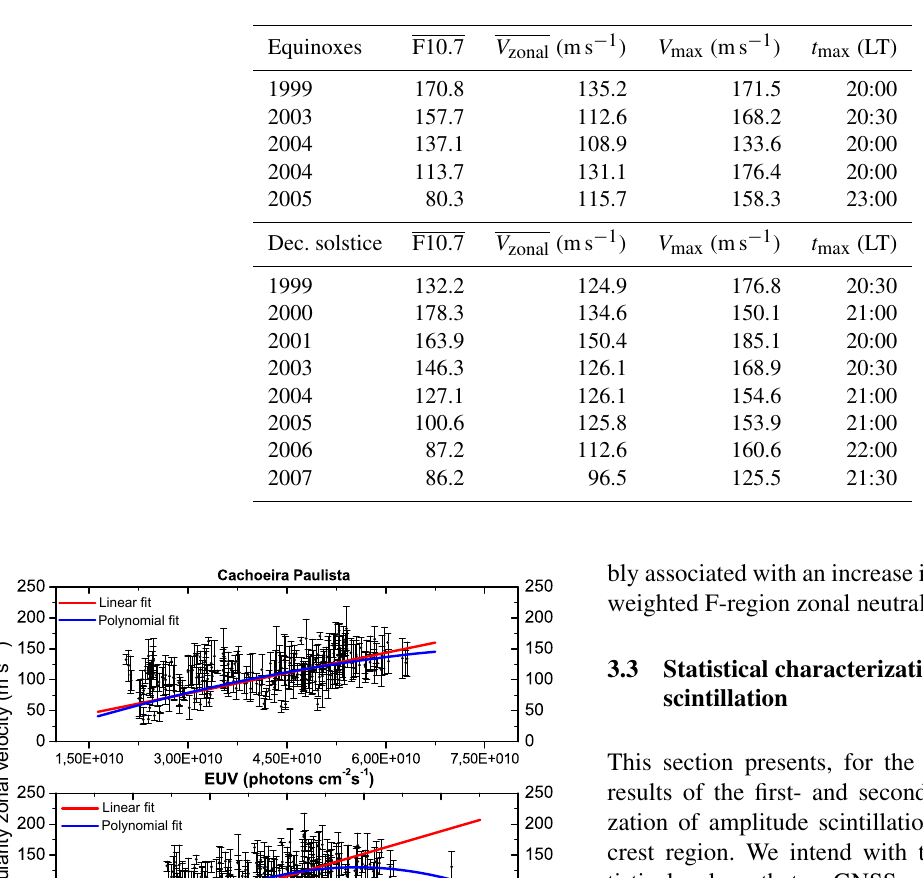
Table 1. Averaged irregularity zonal drifts ( V zonal ), time of occurrence ( t max ) of maximum velocity of the nocturnal variations in mean zonal drifts ( V max ), and the average values of the F10.7 index (in units of 10 − 22 Wm − 2 Hz − 1 ) during the days used to compute the seasonal variations in irregularity zonal drift velocities throughout the years 1998–2007.